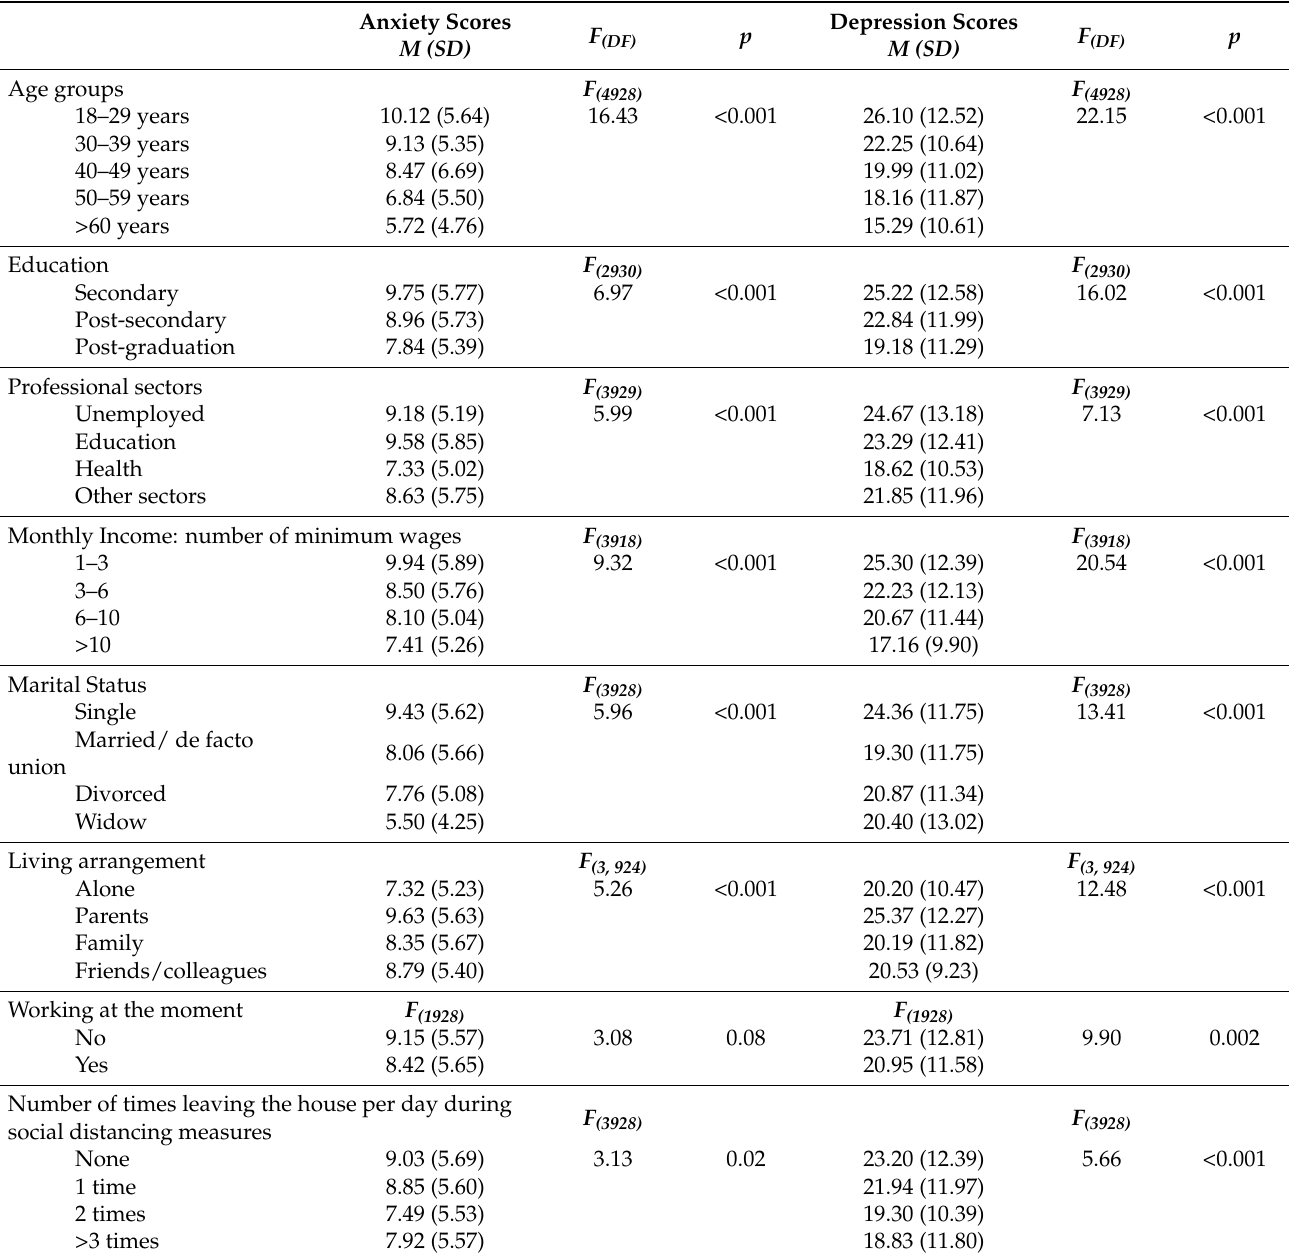
Table 2. Comparisons of anxiety and depression scores according to sociodemographic and COVID-19 characteristics. Anxiety